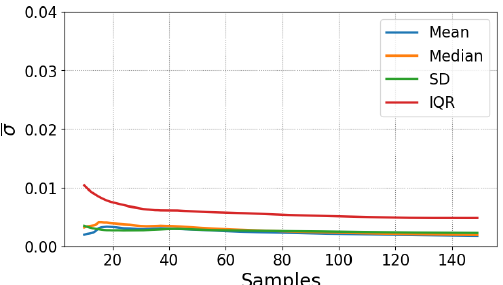
Figure 21. Convergence of the population estimates for a light stall case as the number of tests increases.